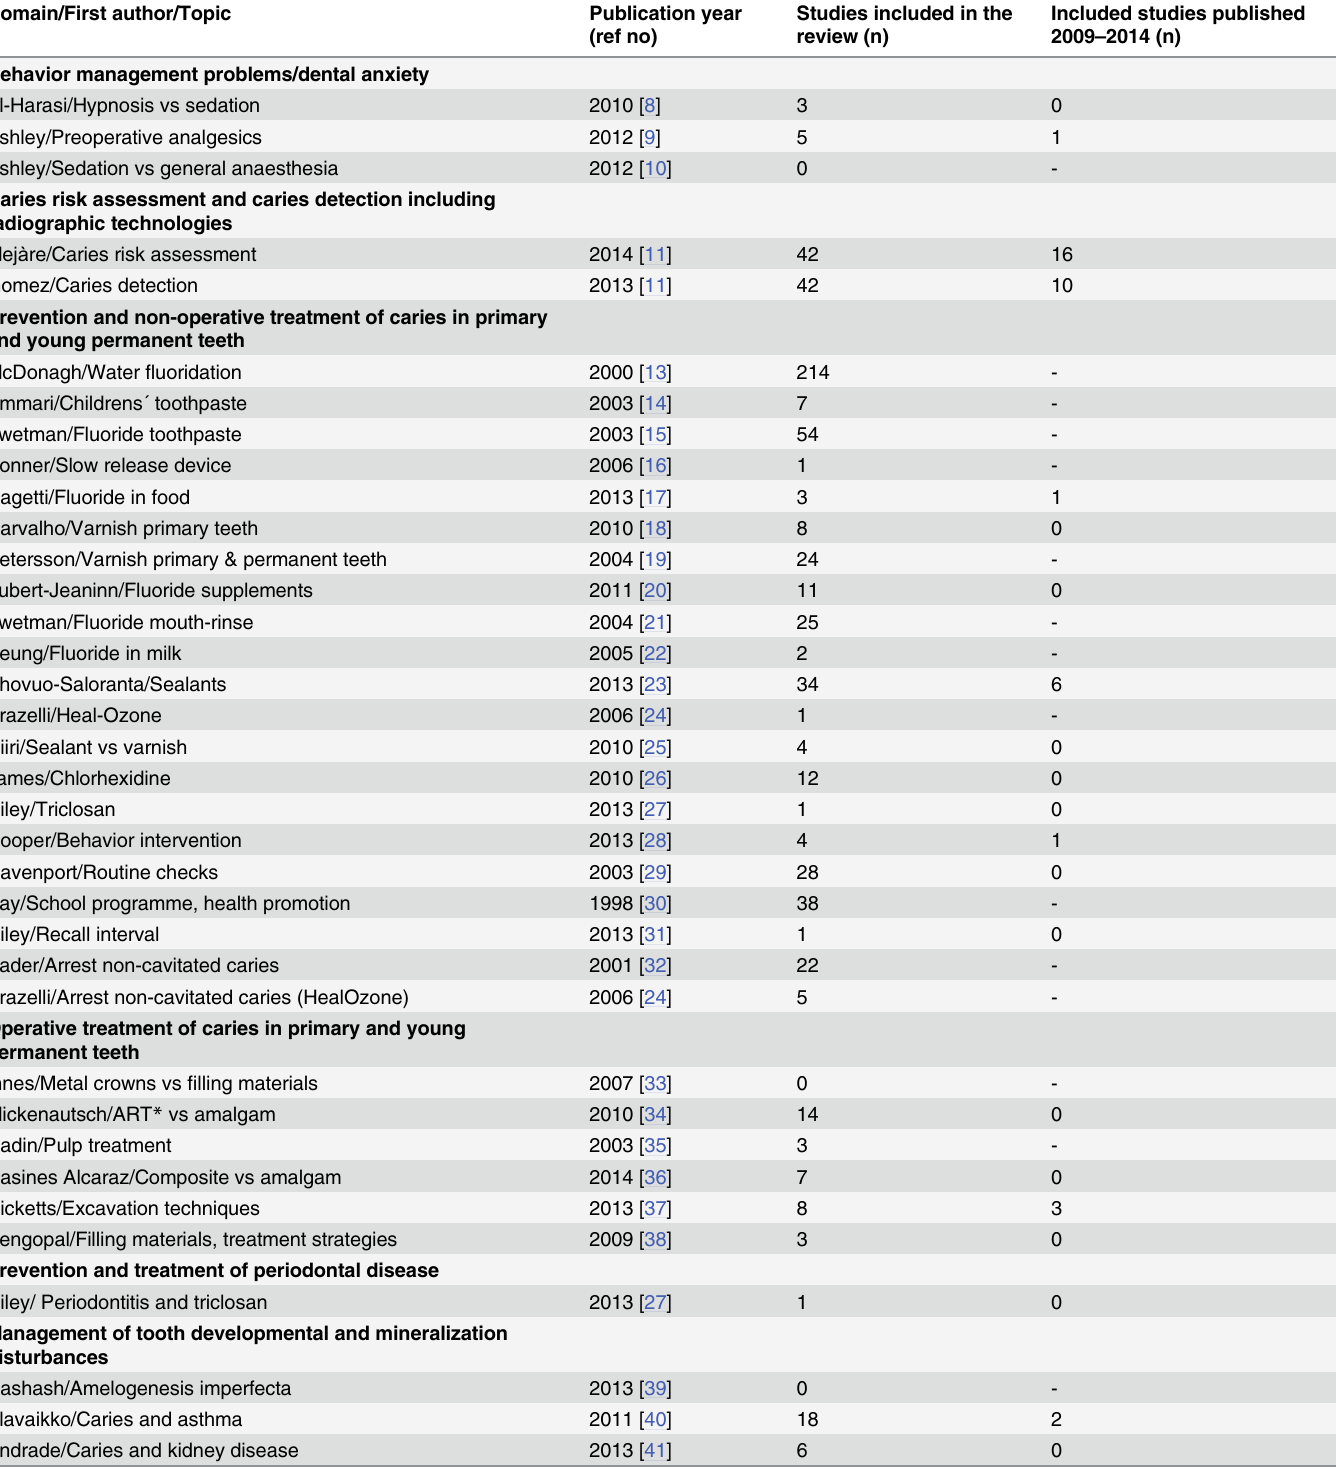
Table 4. Distribution of systematic reviews with low or moderate risk of bias according to publication year, number of included studies and number of included studies published during the last fi ve